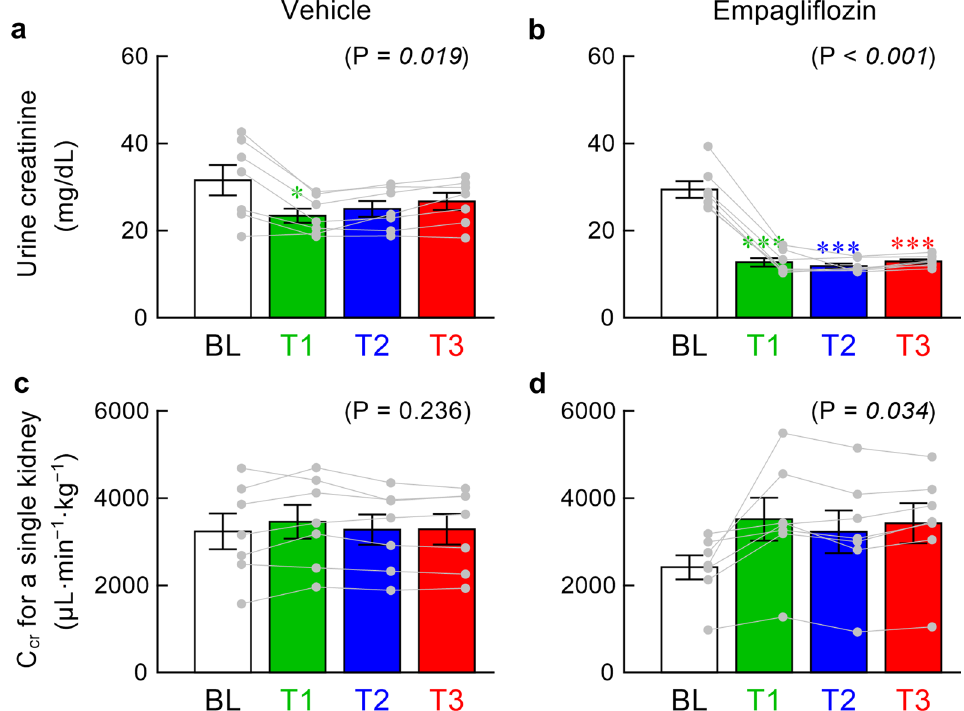
Fig. 4 The upper panels illustrate the urine creatinine concentration during baseline (BL), T1, T2, and T3 periods obtained in the vehicle ( a ) and empagliflozin ( b ) groups. The lower panels illustrate the creatinine clearance (C cr ) for a single kidney during BL, T1, T2, and T3 periods obtained in the vehicle ( c ) and empagliflozin ( d ) groups. Data are presented as mean SE values with data points of the respective rats (n 7 rats each). In each ± = panel, the P value of the repeated-measures one-way analysis of variance (ANOVA) is shown in the parenthesis. The value is italicized when P < 0.05. Symbols * and *** indicate P < 0.05 and P < 0.001 from BL by the post hoc Dunnett’s